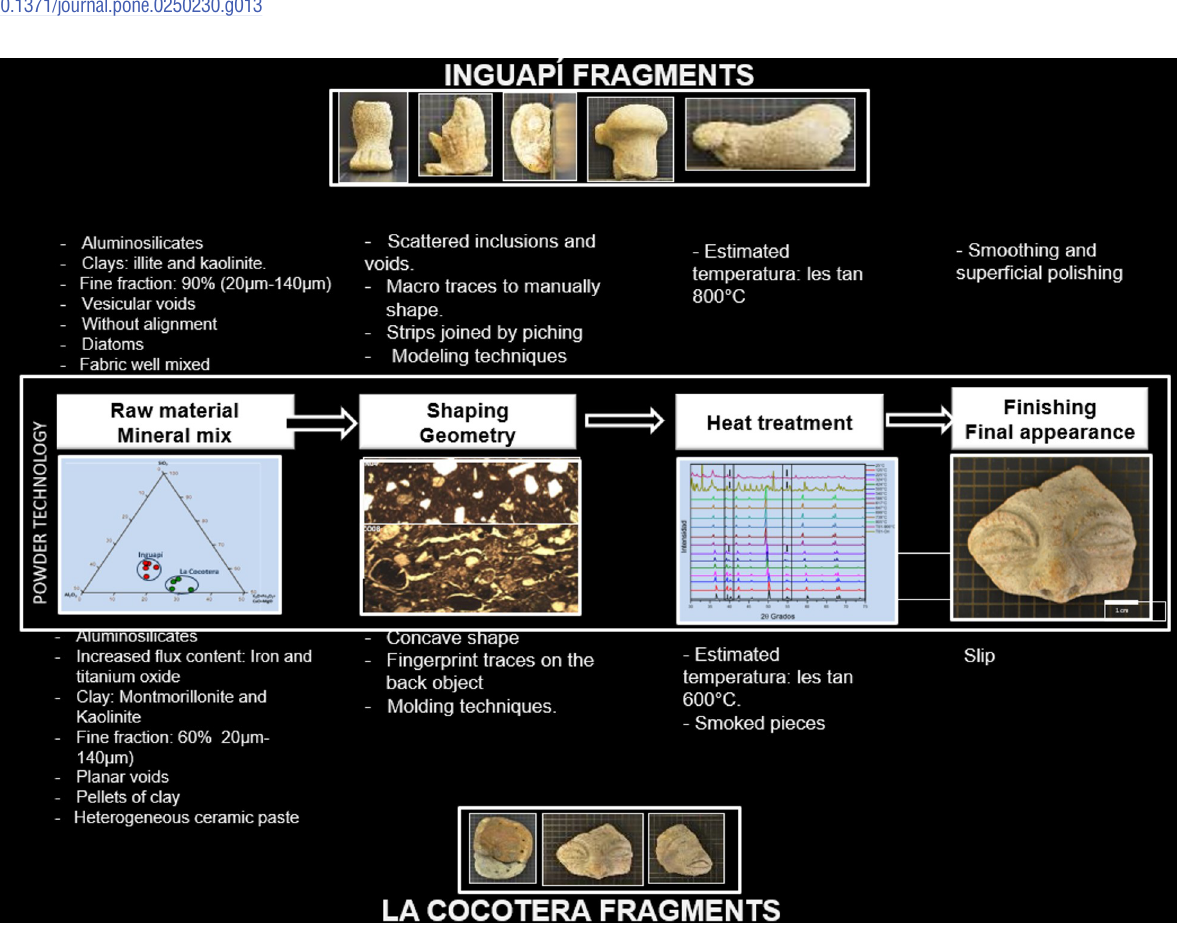
PLOS ONE | https://doi.org/10.1371/journal.pone.0250230 May 5, 2021 22 /